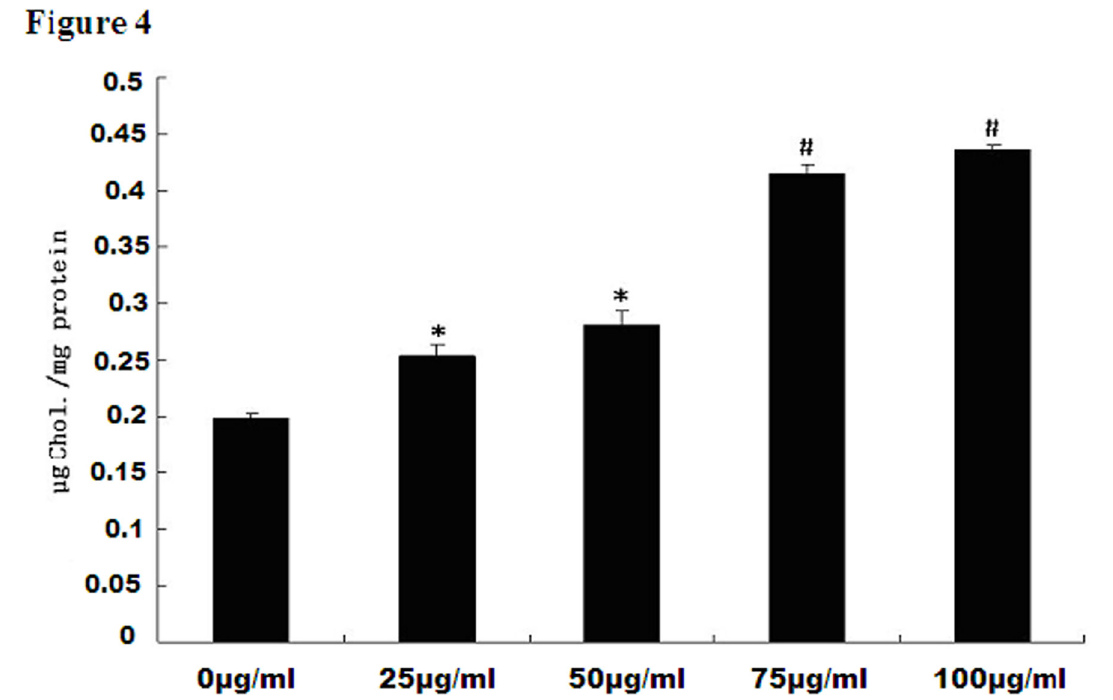
Figure 4. Intracellular free cholesterol concentration after ox-LDL intervention. Differentiated 3T3-L1 adipocytes were exposed to increasing concentrations (0, 25, 50（ 75（ 100µg/ml) of ox-LDL and 10µg/ml ACAT inhibitor Sandoz 58035. Total cell cholesterol level in adipocytes were increased in a dose-dependent manner with ox-LDL intervention. Dates are expressed as mean ±S.D from at least three independent determinations. * P<0.05, as compared with control; # P<0.01, as compared with control. doi: